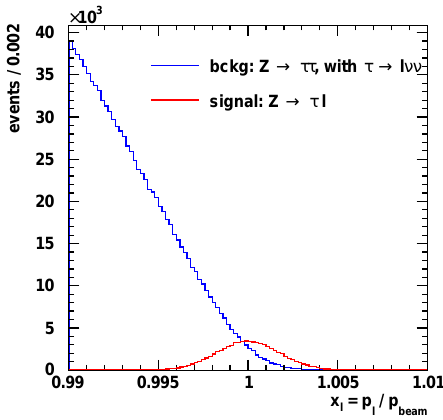
Figure 3: FCC-ee search for the lepton flavour violating decay Z → τ(cid:96) , (cid:96) = e, µ . Momentum distribution of the final state lepton (cid:96) for the signal (red) and for the background from Z → ττ , with τ → (cid:96) ¯ νν (blue). The shown momentum resolution of 1.8 × 10 − 3 results from the combination of the spread on the collision energy (0.9 × 10 3 ) and the detector resolution (1.5 × 10 − 3 ). For illustration, the LVF branch- ing fraction is set here to B ( Z → τ(cid:96) ) = 10 − 7